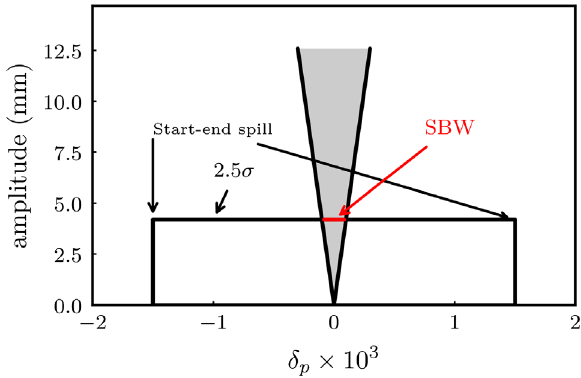
FIG. 2. Steinbach diagram representation of the SPS slow extraction and parameters. The stopband width is approximately (cid:1) 1 × 10 − 4